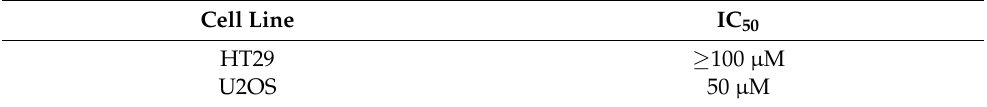
Table 1. IC 50 values of compound 3